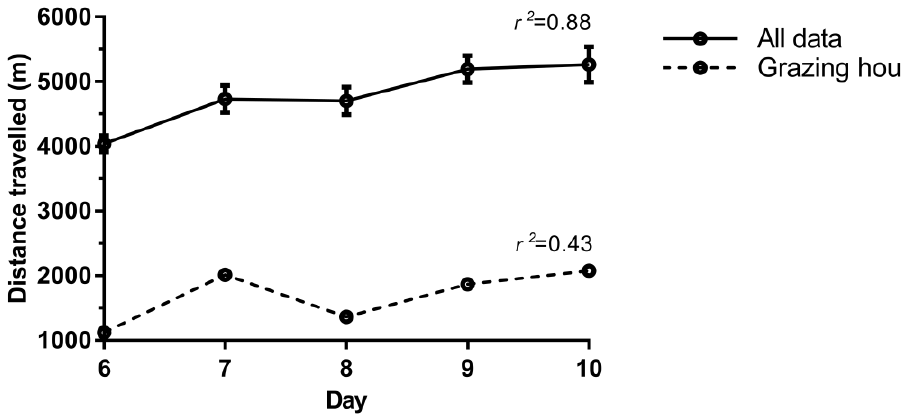
Figure 7. Distance travelled (m/day) during the GNSS collar period (Days 6–10). The total distance travelled over 24 h (All data) and distance travelled during grazing hours (≥50% time spent grazing during behaviour observations). Standard error bars are included for all data. However, as differences between animals during grazing hours were negligible (SEM = 43.9–84.1), error bars are not included.